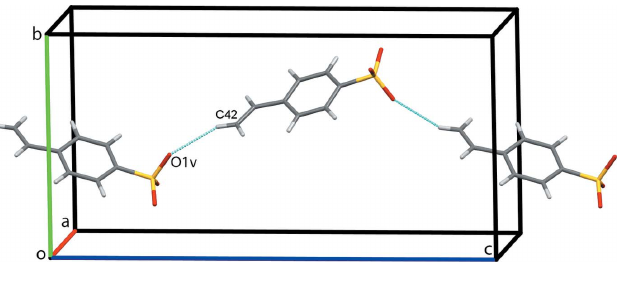
Figure 5 Zigzag chains of anions along c . Hydrogen bonds are shown as cyan dotted lines [symmetry code: (v) 3